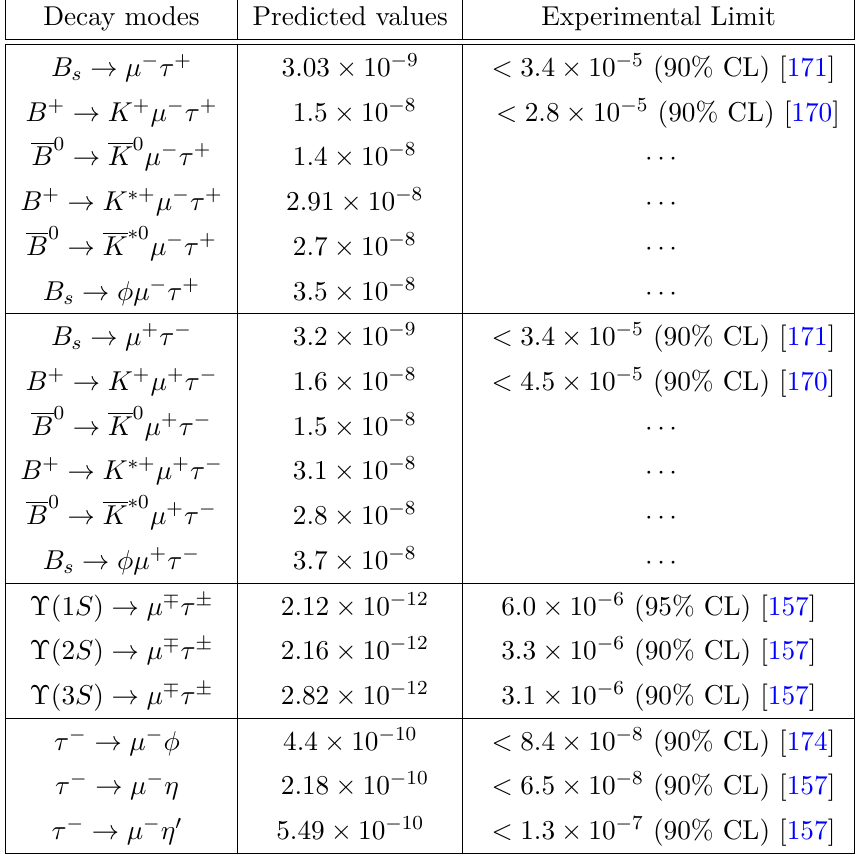
Table 7 . Predicted values of the branching ratios of lepton flavor violating decay channels of B meson and τ lepton in the present